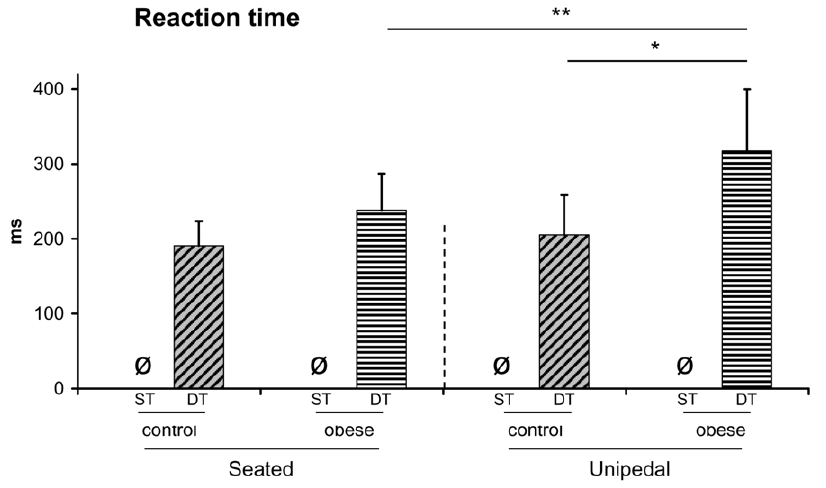
Figure 3. Mean RT and standard deviation for the two groups in the two postural conditions.